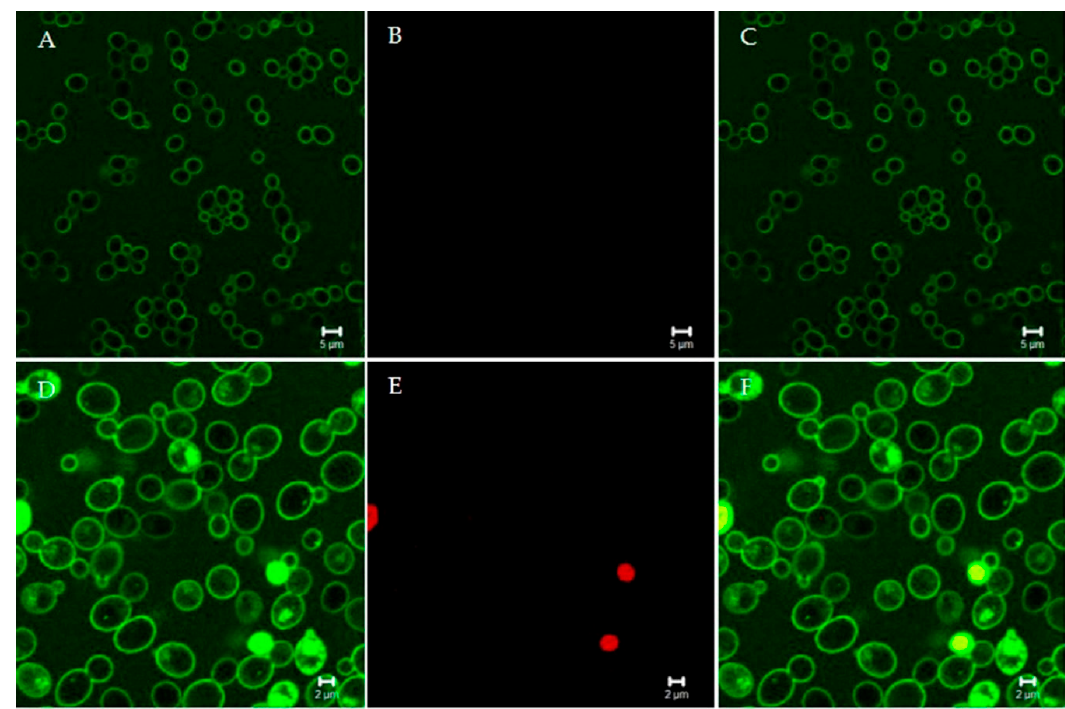
Figure 1. Confocal microscopy images of living Candida albicans cells treated with fluorescein isothiocyanate (FITC)-labeled “killer peptide” (KP). After 170 min of treatment, KP localized on the yeast cell surface ( A ). All yeast cells were viable, as assessed by propidium iodide exclusion ( B ). ( C ) merge of panels A and B. After 380 min of treatment, KP entered yeast cells ( D ). Some yeast cells were no longer viable, as assessed by propidium iodide internalization ( E ). ( F ) merge of panels D and E. Bar: 5 µm (panels A, B, and C); 2 µm (panels D, E, and F). The slow killing effect suggests a non-membranolytic mode of action.